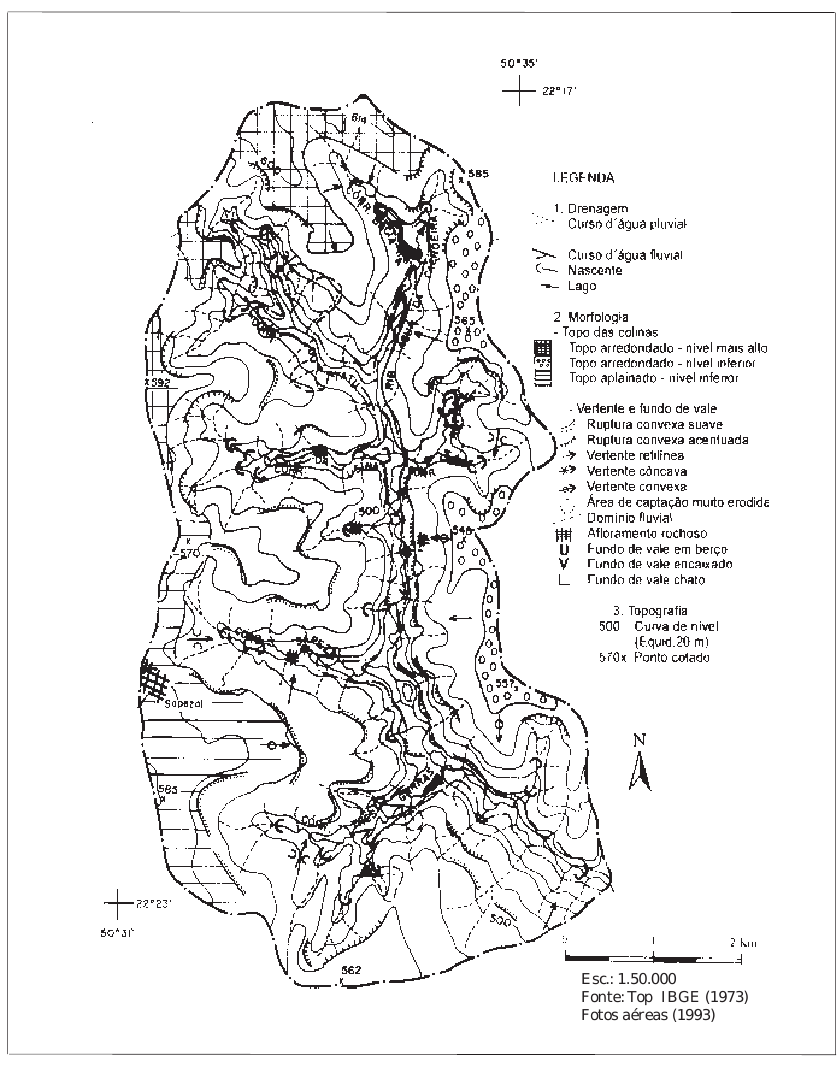
Figura 2. Topografia, drenagem e morfologia da microbacia do ribeirão Água da Cachoeira, em Paraguaçu Paulista